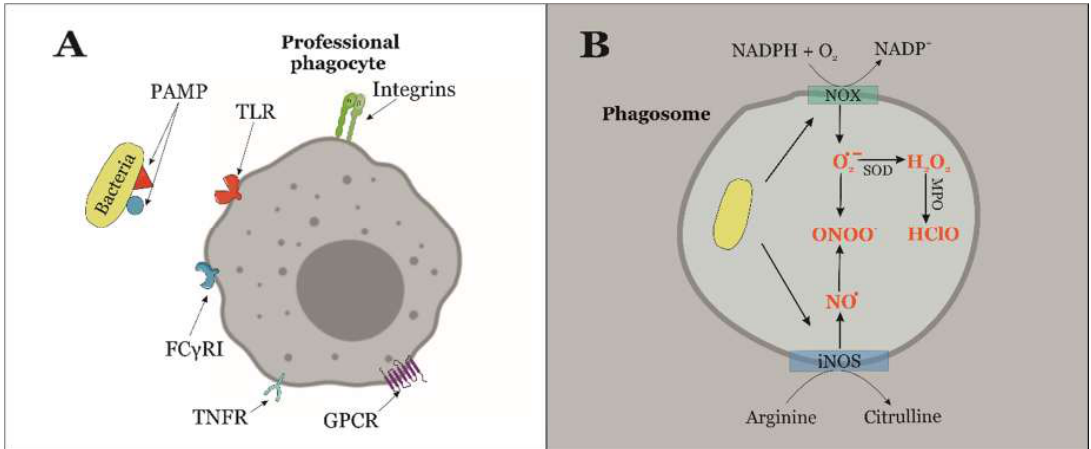
Figure 1. ( A ) During infection, pathogen-associated molecular patterns (PAMPs) are recognized by pattern recognition receptors (PRRs) which are present on the surface of professional phagocytes. PRRs include integrins, toll-Like receptors (TLRs), Fc receptors such as FCγRI, tumor necrosis factor receptors (TNFRs), and G Protein-Coupled Receptors (GPCRs). ( B ) RONS synthesis is triggered during phagocytosis to generate a bactericidal oxidative stress. There are different enzymes involved on this process, including NADPH oxidases (NOX), nitric oxide synthases (iNOS), superoxide dismutates (SOD), and myeloperoxidases (MPO).